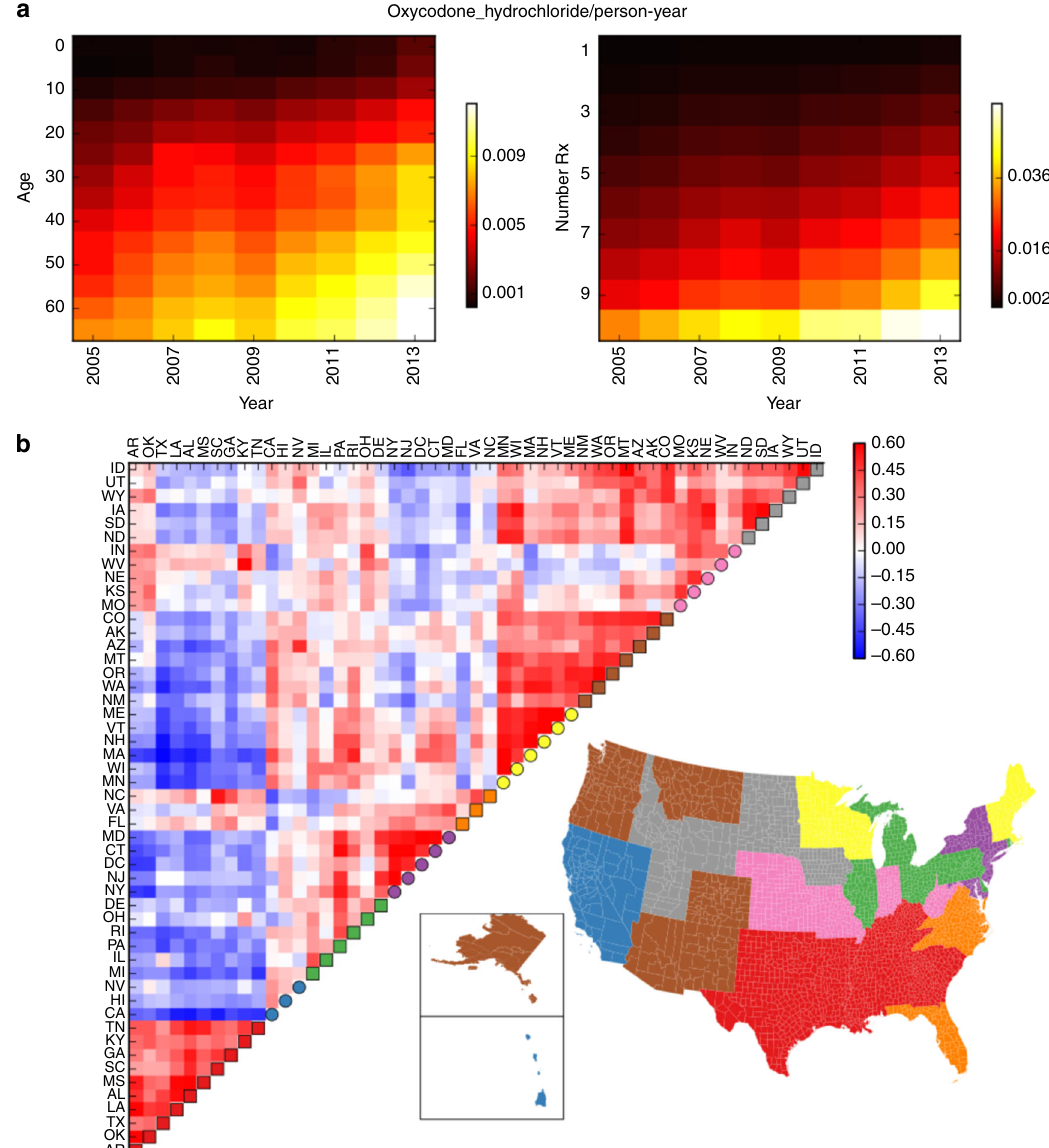
Fig. 1 Quantifying variation in drug use, and comparing states by departure from expected drug use. a The probability that a person who could be prescribed oxycodone hydrochloride will have a record for this prescription, is shown as a function of year, age and number of prescriptions in that person- year. This probability increases over years. b We generate drug deviance vectors for each state, which represent how much more or less of each drug is used in the state as compared with the nation-wide model. Clustering states by their Spearman correlation in these vectors (see color scale) recovers known similarities between states. We create non-overlapping clusters (legend for each state appears on diagonal) and color the map of the country